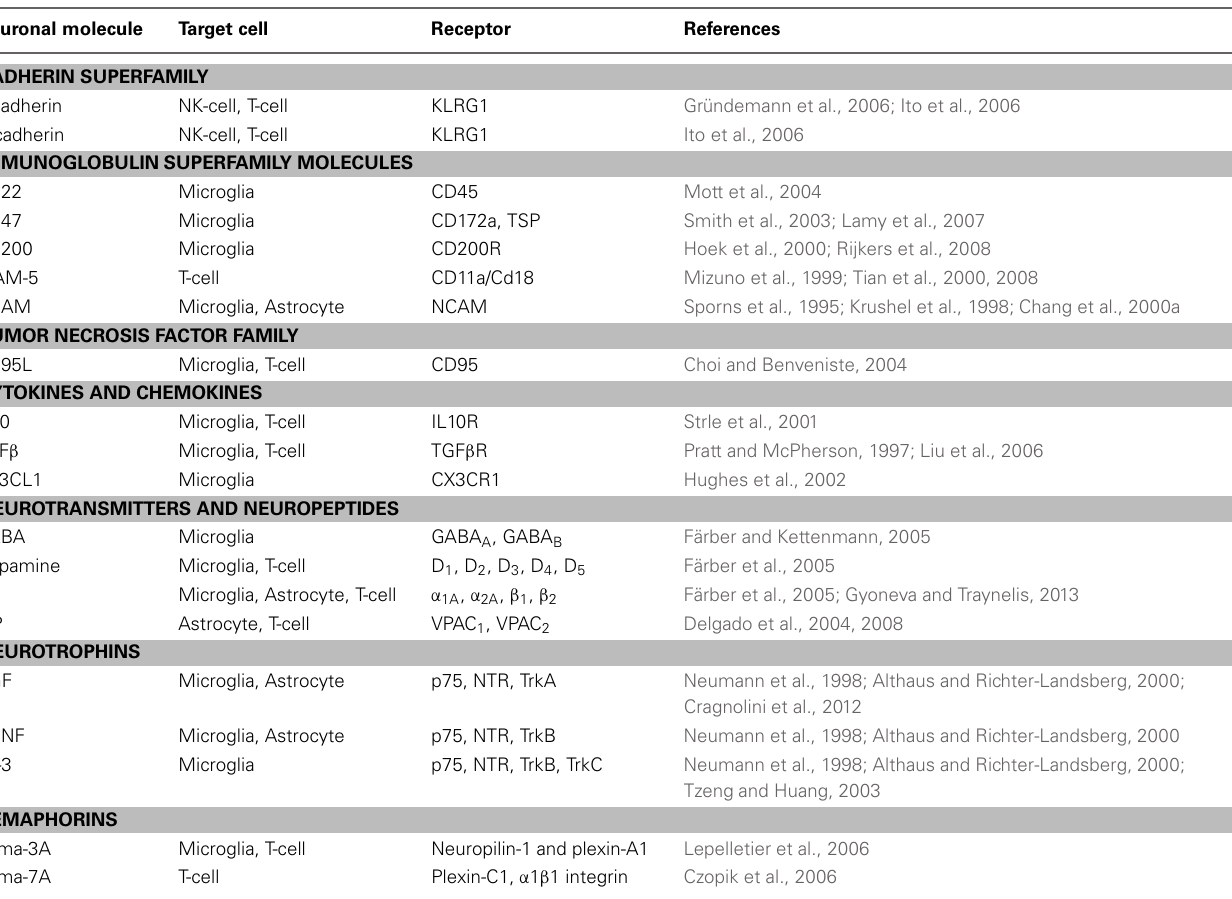
Table 1 | Main neuronal immune regulatory molecules, their receptors and target cells in the CNS. Neuronal